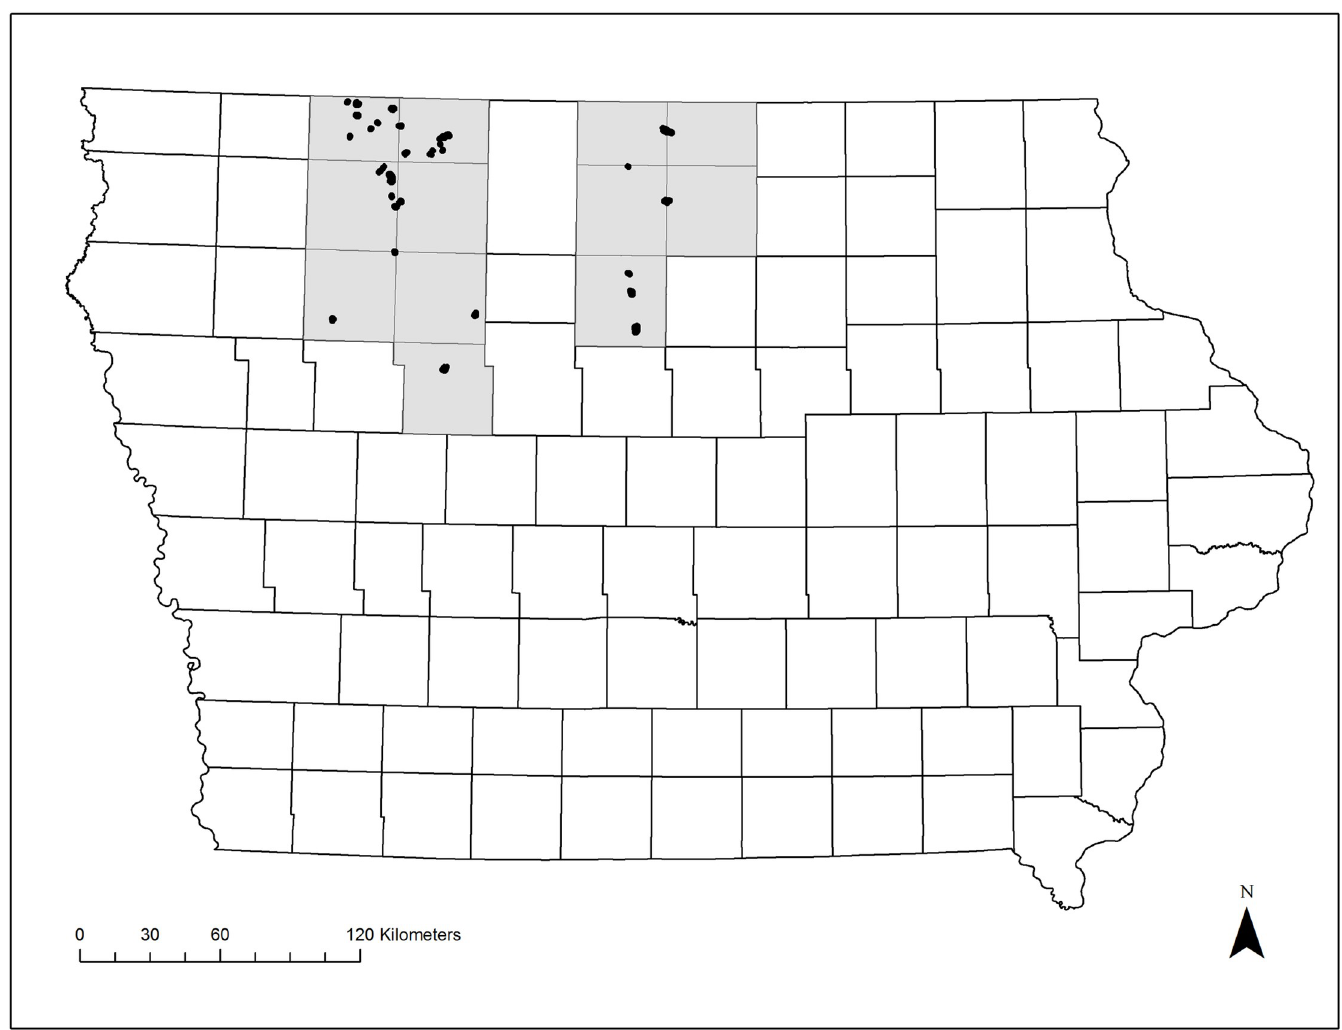
Fig 1. Location of shallow lakes in the Iowa Prairie Pothole Region (gray outline) for breeding marsh bird surveys conducted in the summer, 2016 and 2017. Each black dot represents a site, and the 12 shaded counties are those that include the surveyed